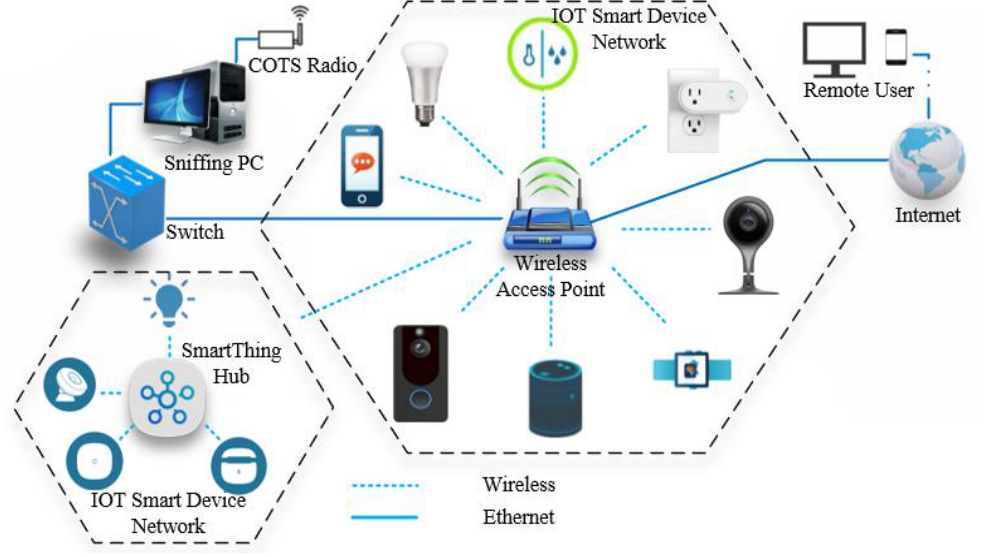
Figure 2. Internet of things (IoT) testbed environment setup.